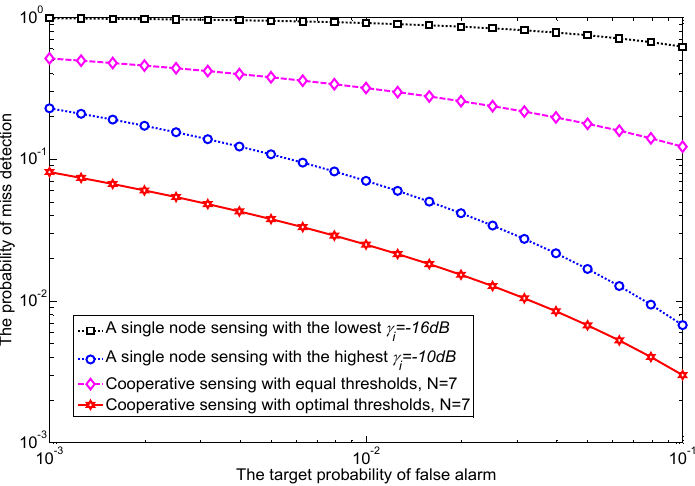
Figure 6. Receiver operating characteristic (ROC) curves for a single node sensing and cooperative sensing; different SNRs are considered in cooperation with both an equal threshold and optimal